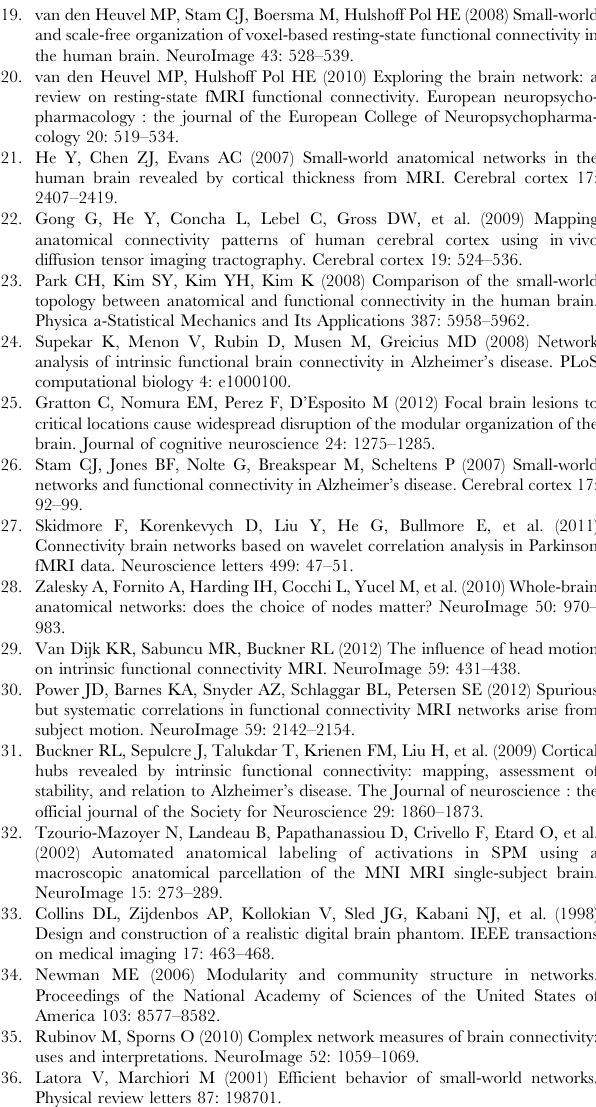
(TIF) Table S1 Brain regions showing a high degree centrality (control group; t . 6.0). MNI-coordinates, t-scores and anatomical regions of local maxima. (DOCX) Table S2 Nodes in the visual (module 4) and sensorimotor network (module 6) showing the strongest between group effects in degree centrality. Table S3 Group differences in degree centrality (voxel degree analysis;